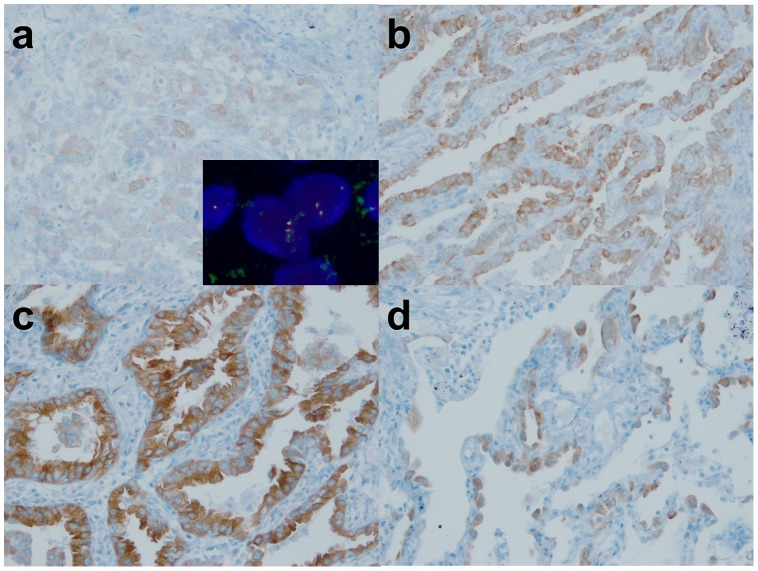
Immunohistochemical findings of ROS1-non-rearranged tumors.Most ROS1-non-rearranged tumors showed no immunoreactivity, or focal and patchy staining with weak intensity (a, b) (inset: ROS1 FISH without split signals). One tumor showed strong and diffuse staining pattern, which is similar to that of rearranged tumors (c). ROS1 is occasionally expressed in surrounding type II pneumocytes (d).